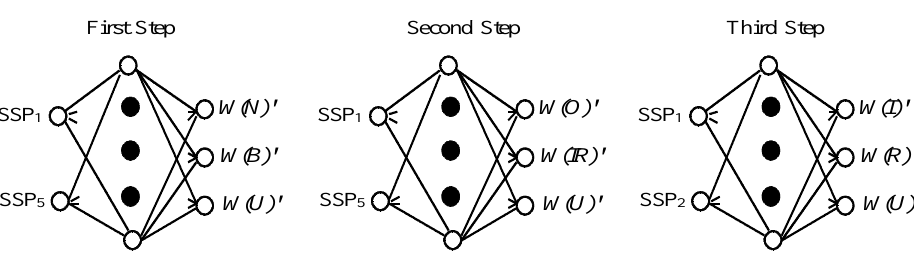
Figure 11. Partially-linearized neural network for condition